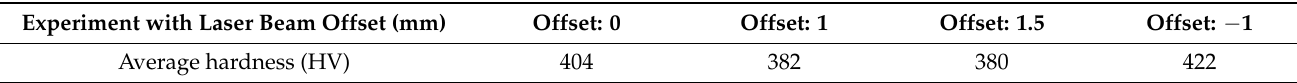
Table 7. The average hardness values of the welded joints with different laser beam offsets. Experiment with Laser Beam Offset (mm)